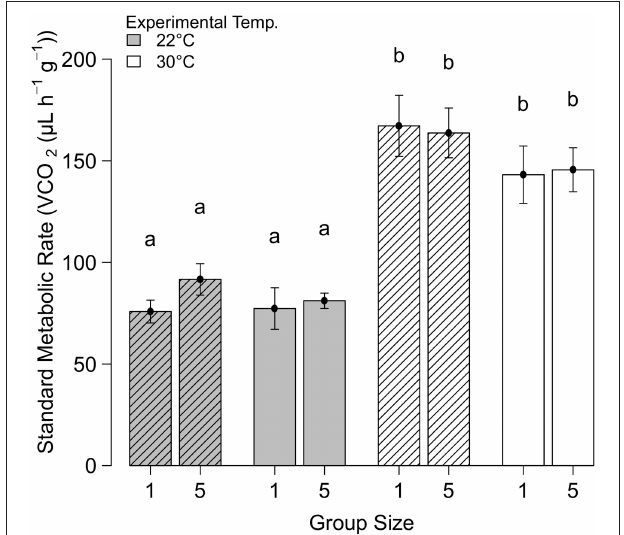
FIGURE 1 | The standard metabolic rate (mean ± SE) of Stegodyphus dumicola spiders kept individually and in group size of five, acclimated to two temperatures (22 ◦ C = clear and 30 ◦ C = hatched), and measured at 22 and 30 ◦ C. Letters indicate significant differences.